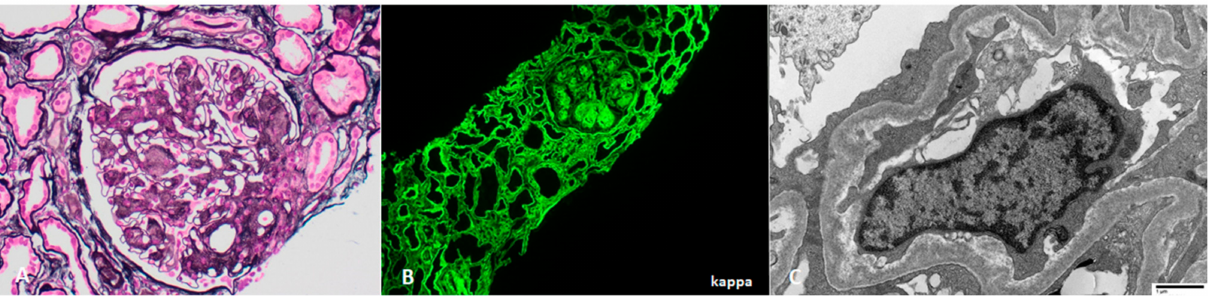
Figure 5. Monoclonal immunoglobulin deposition disease, with ( A ) a nodular glomerulopathy (Jones 200 × ), ( B ) diffuse staining of glomeruli, tubular basement membranes, and interstitium, usually for one light or heavy chain by immunofluo- rescence, and ( C ) punctate “gunpowder” immune deposits by EM (direct mag 4800 ×